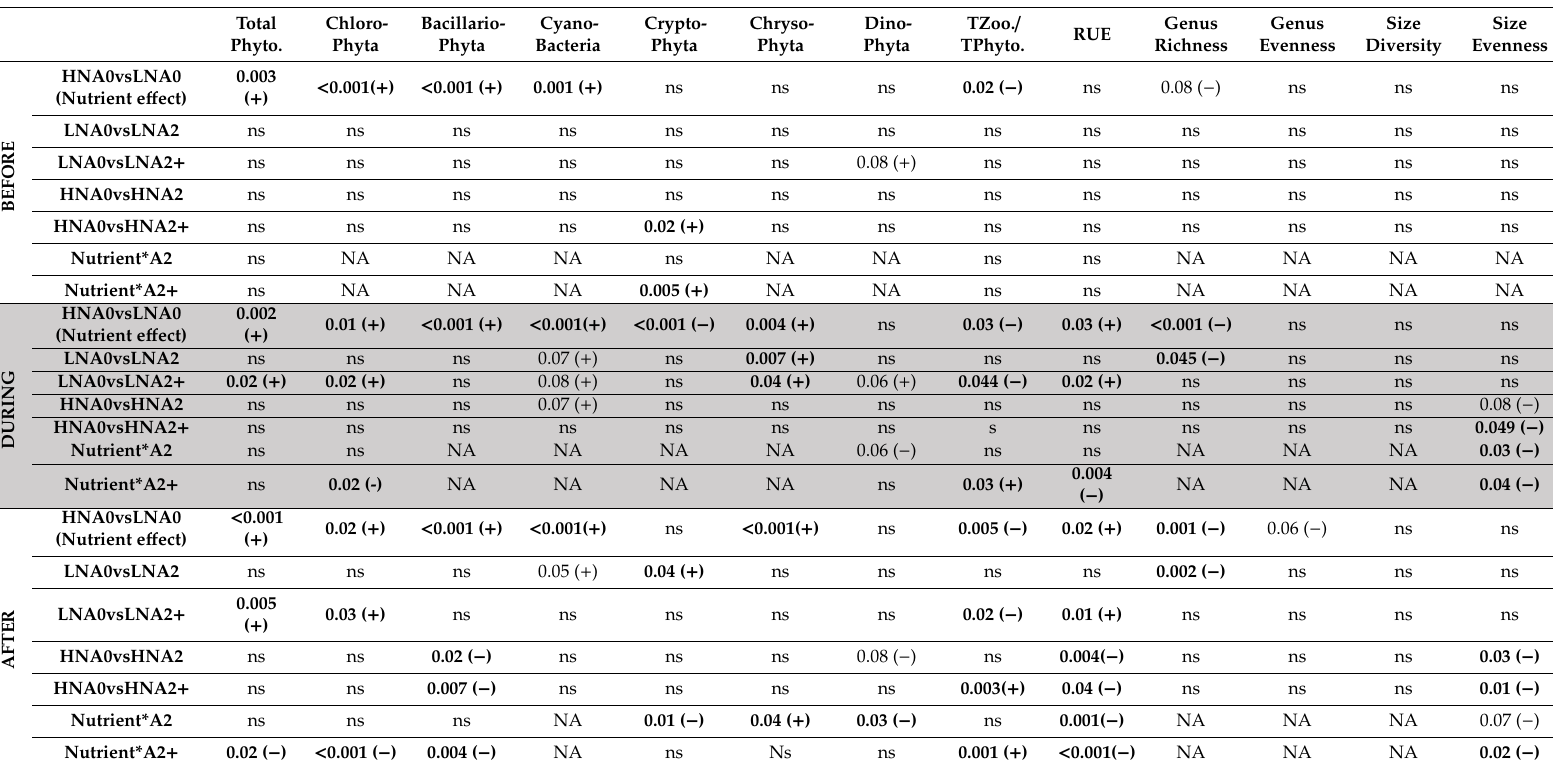
Table 2. p values of LMMs (bold values indicate p < 0.05, heat wave period (during) is highlighted, (*) refers to interaction models and NA refers to higher AIC of models with interactions. Note that the ‘Nutrient’ rows include results from comparison of HN-A0 with LN-A0 in all three periods not exposed to HW, ( + ) and ( − ) were used for higher and lower e ff ects than in A0,